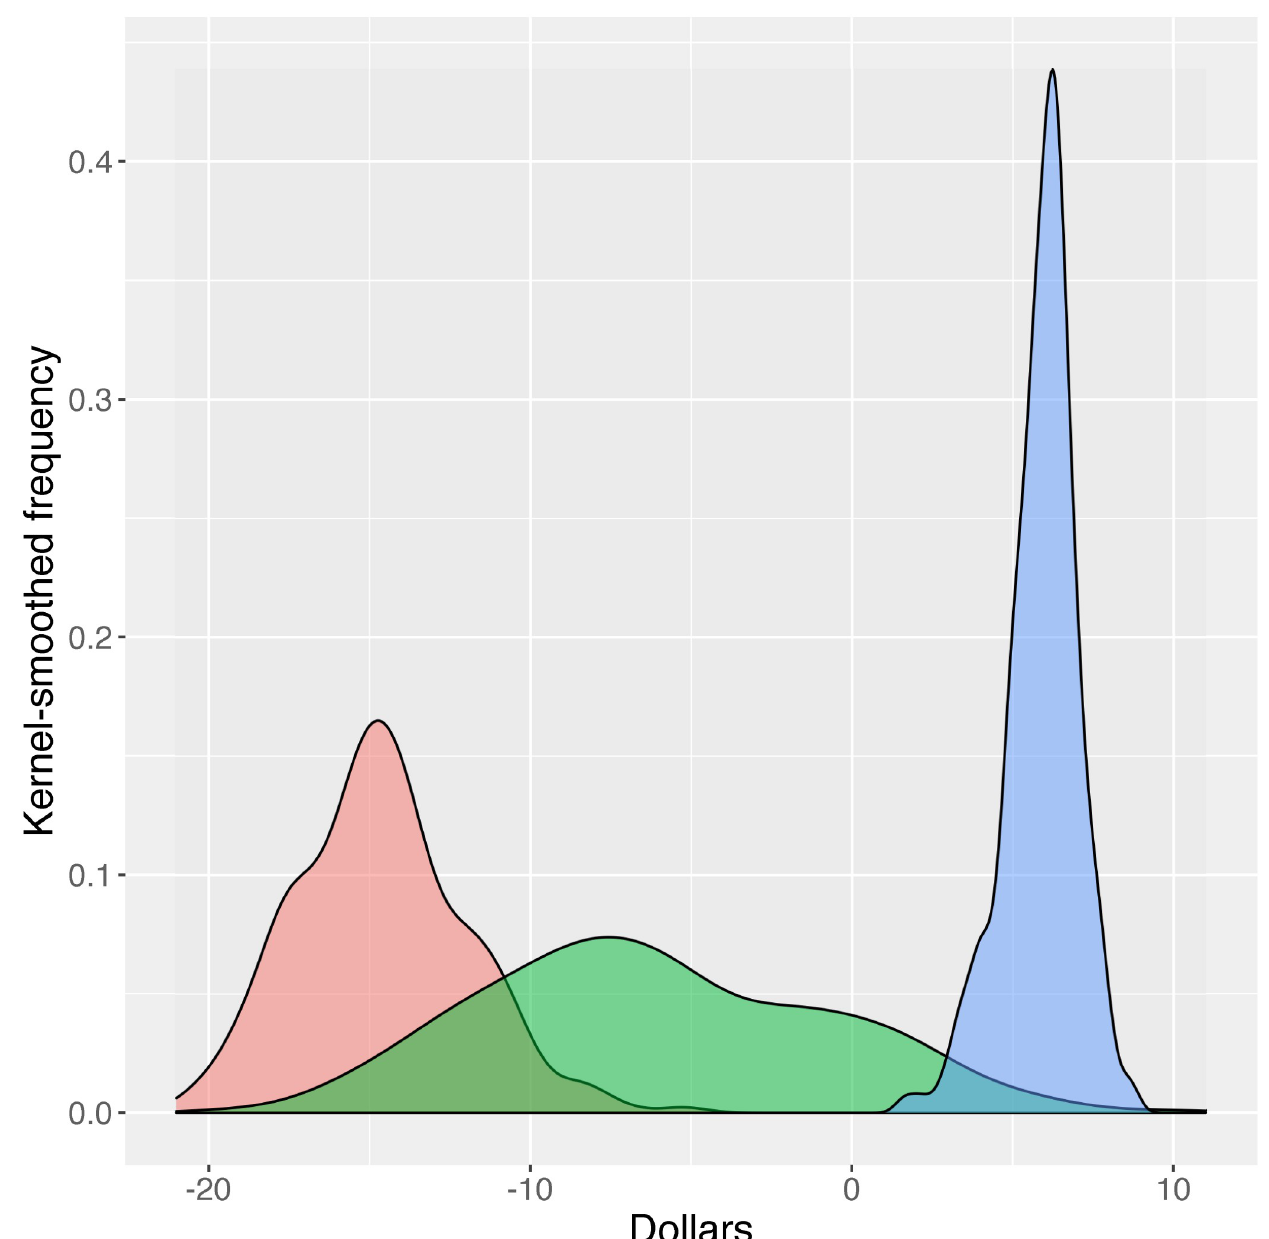
Fig 5. Mean willingness to pay for PrEP among 236 young men who have sex with men in the U.S.: Additional options. Red: Wait 4 weeks to start PrEP, compared to immediate start; Green: Wait 1 week to start PrEP, compared to immediate start; Blue: Communicate with provider online, compared to in- person